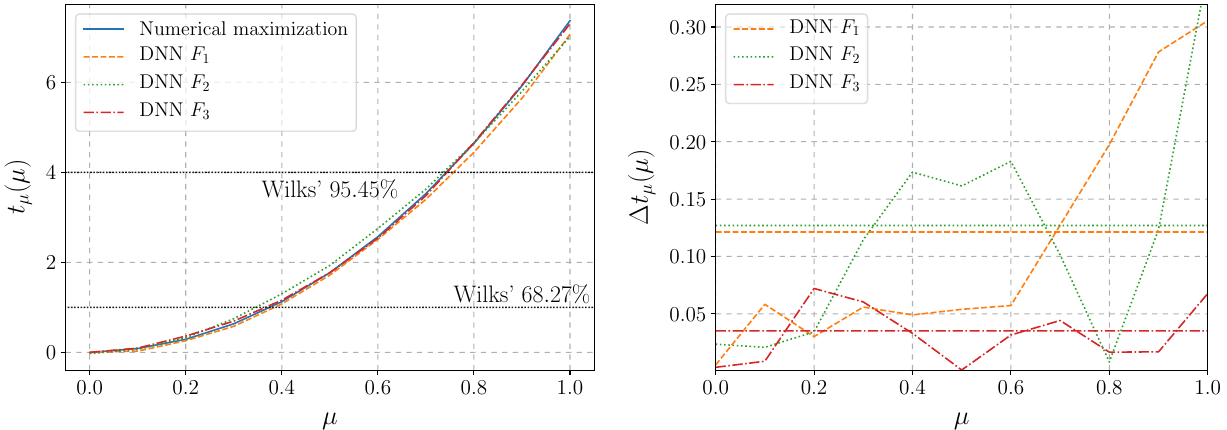
Fig. 13 Comparison of the t μ test-statistics computed using numeri- cal maximisation of the analytic likelihood and of the DNNLikelihoods F 1 − F 3 . Each of the t μ prediction from the DNNLikelihoods corre- sponds to the best out of five trained models. The left and right plots